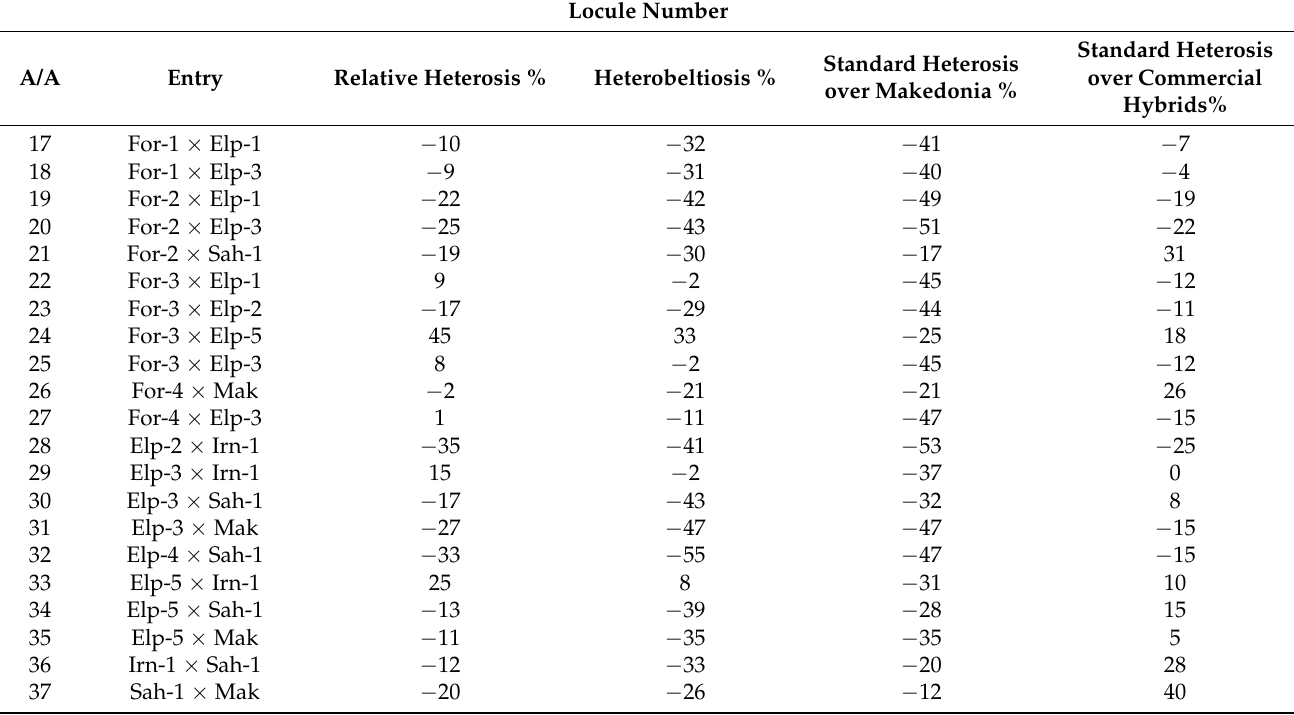
Table 11. Relative heterosis, heterobeltiosis, and standard heterosis of the original commercial hybrids, the new recombinant inbred lines, and the reconstructed new hybrids, as for locule